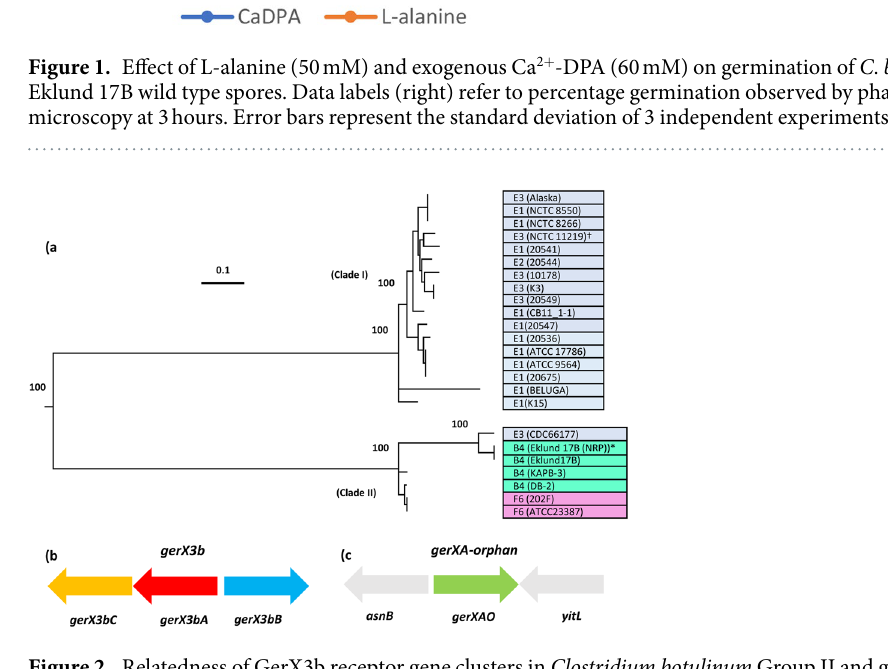
Figure 2. Relatedness of GerX3b receptor gene clusters in Clostridium botulinum Group II and genetic organization of the gerX subtypes. ( a ) Relatedness of gerX3b types in C . botulinum Group II (toxin types shown in coloured boxes). gerX associated proteins used for comparisons; gerX3bA (Locus tag; CB17B_RS15165), gerX3bB (Locus tag; CB17B_RS15170), gerX3bC (Locus tag; CB17B_RS15160) and gerXAO (Locus tag; CB17B_RS12225). * Represents strain C . botulinum Eklund 17B (NRP) (Accession number; FR745875) used in this study. † Represents strain C . botulinum NCTC 11219 for comparison. Clade I consist of strains forming neurotoxin type E, and Clade II includes strains forming type neurotoxin types B, E or F. Strains used for comparison of the gerX3b types see Brunt et al . 37 . The phylogenetic tree is based on single nucleotide polymorphisms (SNPs). Values shown at branches represent bootstrap values provided by ParSNP. ( b ) Genetic organization of the gerX3b gene cluster. ( c ) gerXAO is flanked by asparagine synthetase ( asnB ) and an uncharacterized S1 RNA binding domain protein ( yitL